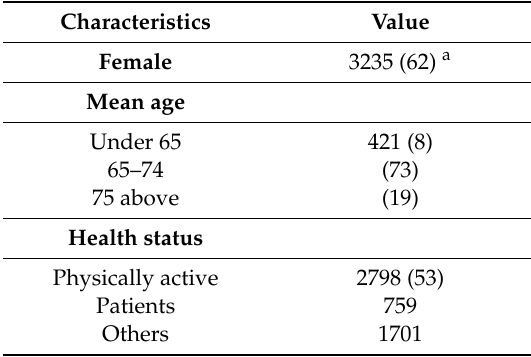
Table 3. Participants